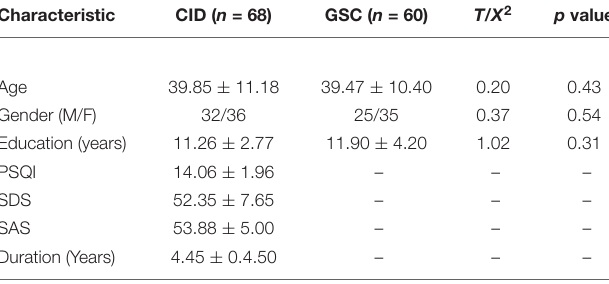
FC network, CID patients had decreased FC in the dorsal anterior cingulate cortex (dACC). Taken together, the altered regions in the LC-NE network were all located in the efferent pathway, and the areas with increased FC were located in the sensory cortex, while those with decreased FC were found in the prefrontal cortex.